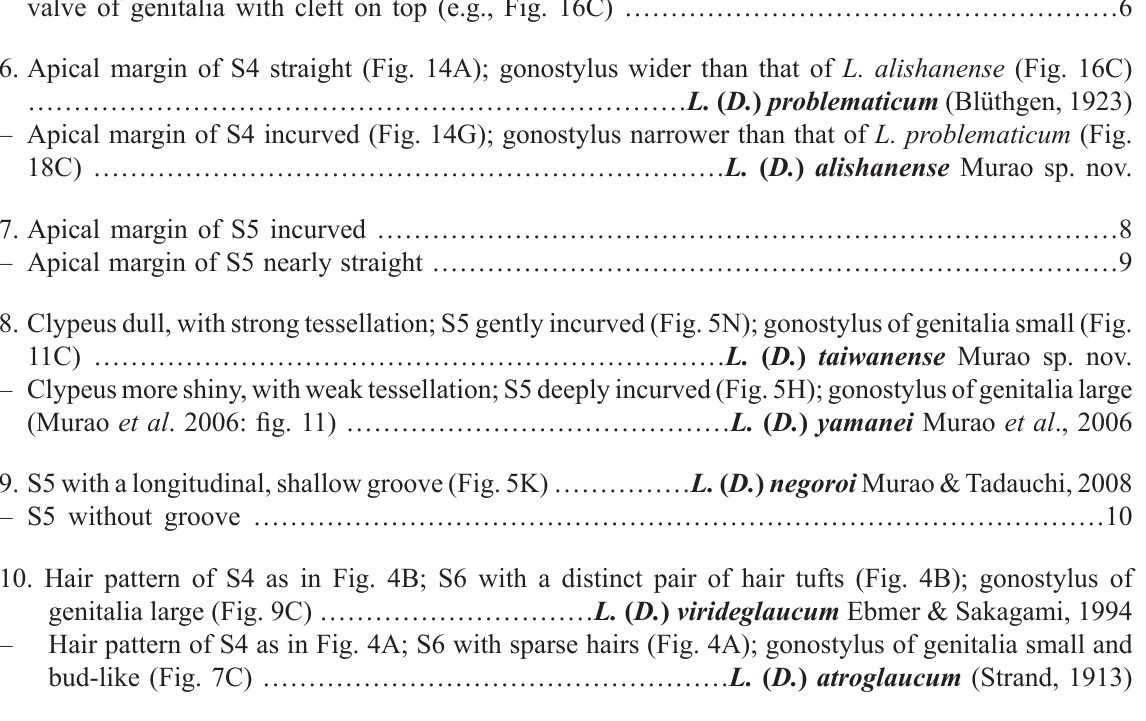
A checklist of Lasioglossum (Dialictus) in Japan, the Korean Peninsula and Taiwan: The leucopus group: Lasioglossum ( Dialictus ) pseudannulipes (Blüthgen, 1925): Japan Lasioglossum ( Dialictus ) viridellum (cockerell, 1931): Korean Peninsula Lasioglossum ( Dialictus ) meakanense Murao & Tadauchi, 2009: Japan The atroglaucum